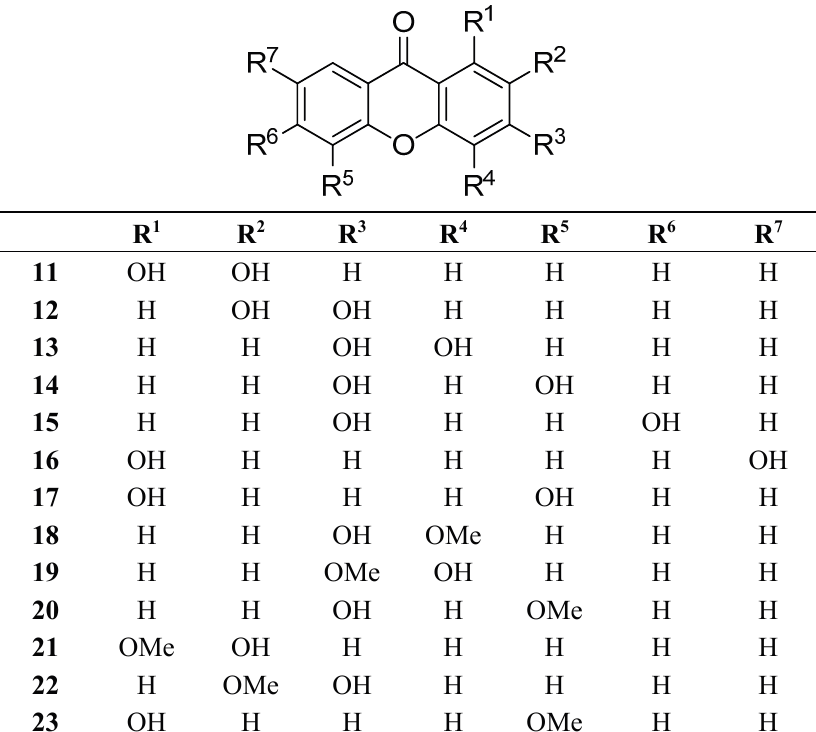
Figure 1. Chemical structures of tested monooxygenated xanthones.